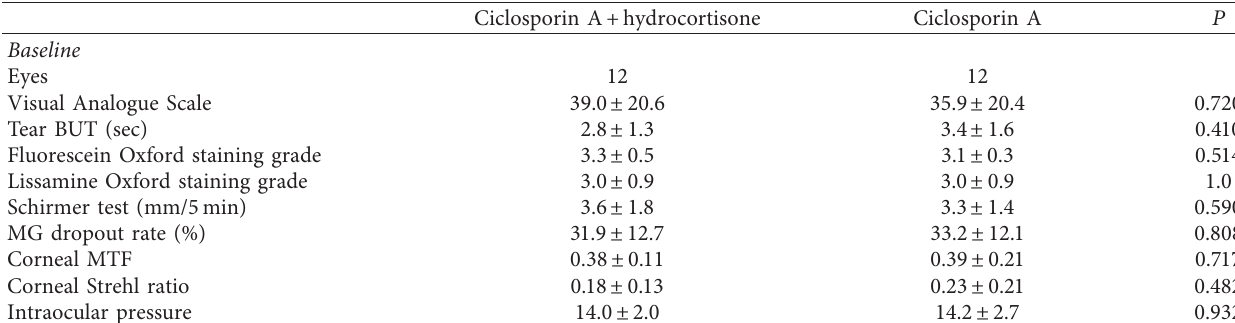
Table 2: Study parameters at baseline compared between the two treatment regimens.